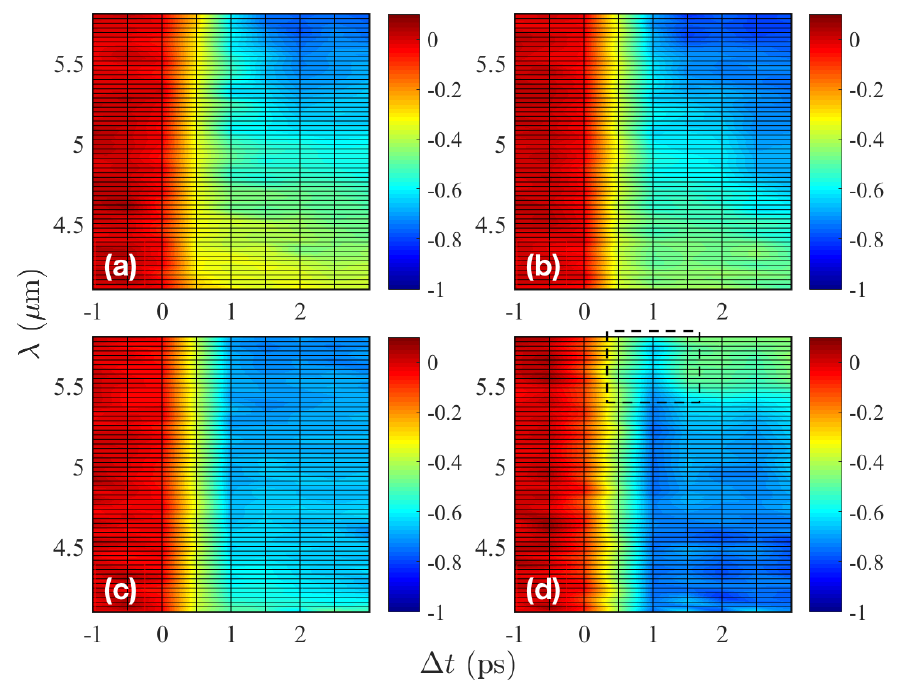
Figure 2. The change of the reflectance, ∆ R / R 0 , as a function of the arrival time difference, ∆ t , between the pump and signal pulses, and the signal wavelength λ for the pump fluences of 3.8 mJ/cm 2 ( a ), 5.0 mJ/cm 2 ( b ), 6.3 mJ/cm 2 ( c ) and 8.8 mJ/cm 2 ( d ). The dashed box in ( d ) shows the region where the reflectance passes through the